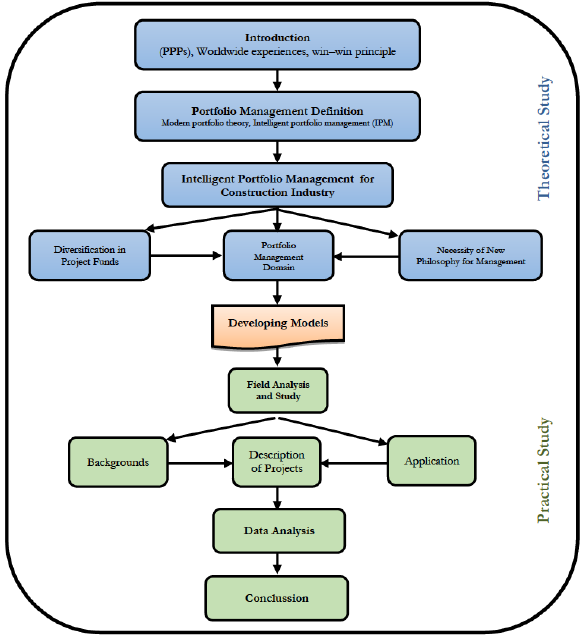
Figure 1: Flowchart of the research